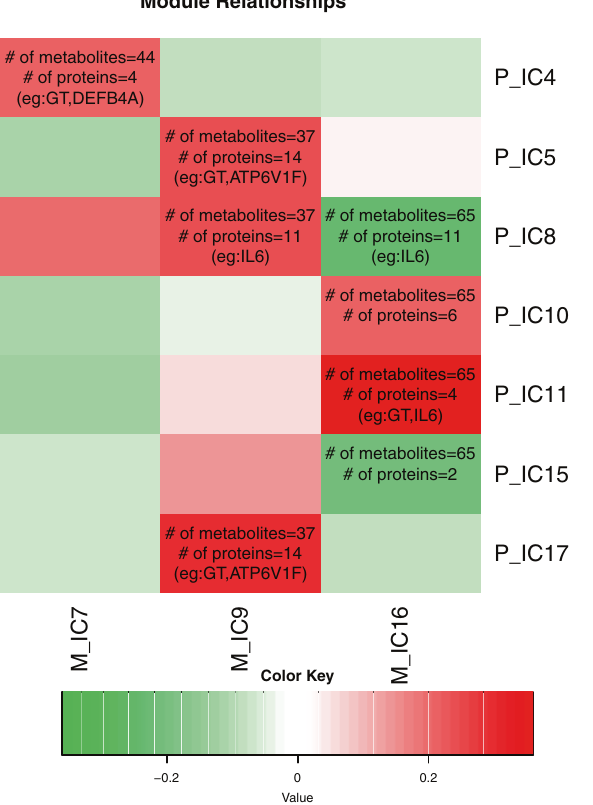
Supplementary Fig. 1. The list of proteins and metabolites, along with the estimated source signal in each module are provided in Supplementary Table 5.